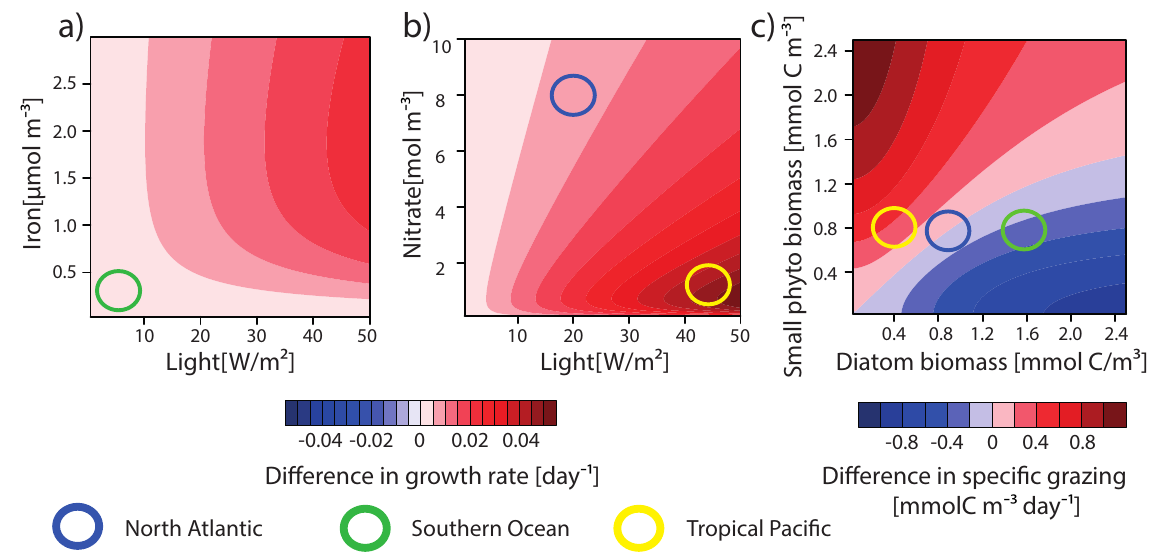
Fig. 6. (a) and (b) Difference between small phytoplankton growth rate and diatom growth rate at different nitrate, iron and light values. Typical values for regions discussed in the text are marked with coloured circles. The Southern Ocean is a mainly iron-limited region, while the subtropical gyres and the North Atlantic are mainly nitrate-limited. The growth rate [ 1 to obtain the total growth. (c) Small phytoplankton-specific grazing/diatom-specific grazing at different phytoplankton biomass levels and constant